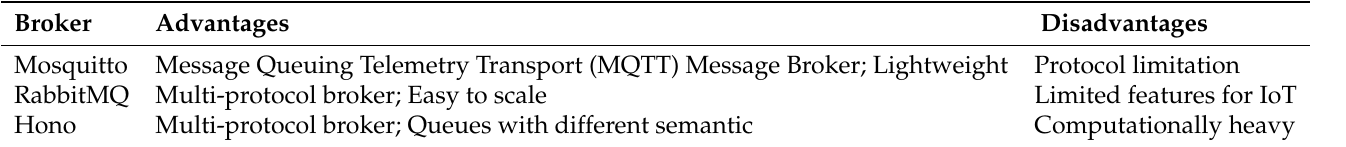
Table 1. IoT Messages brokers review.